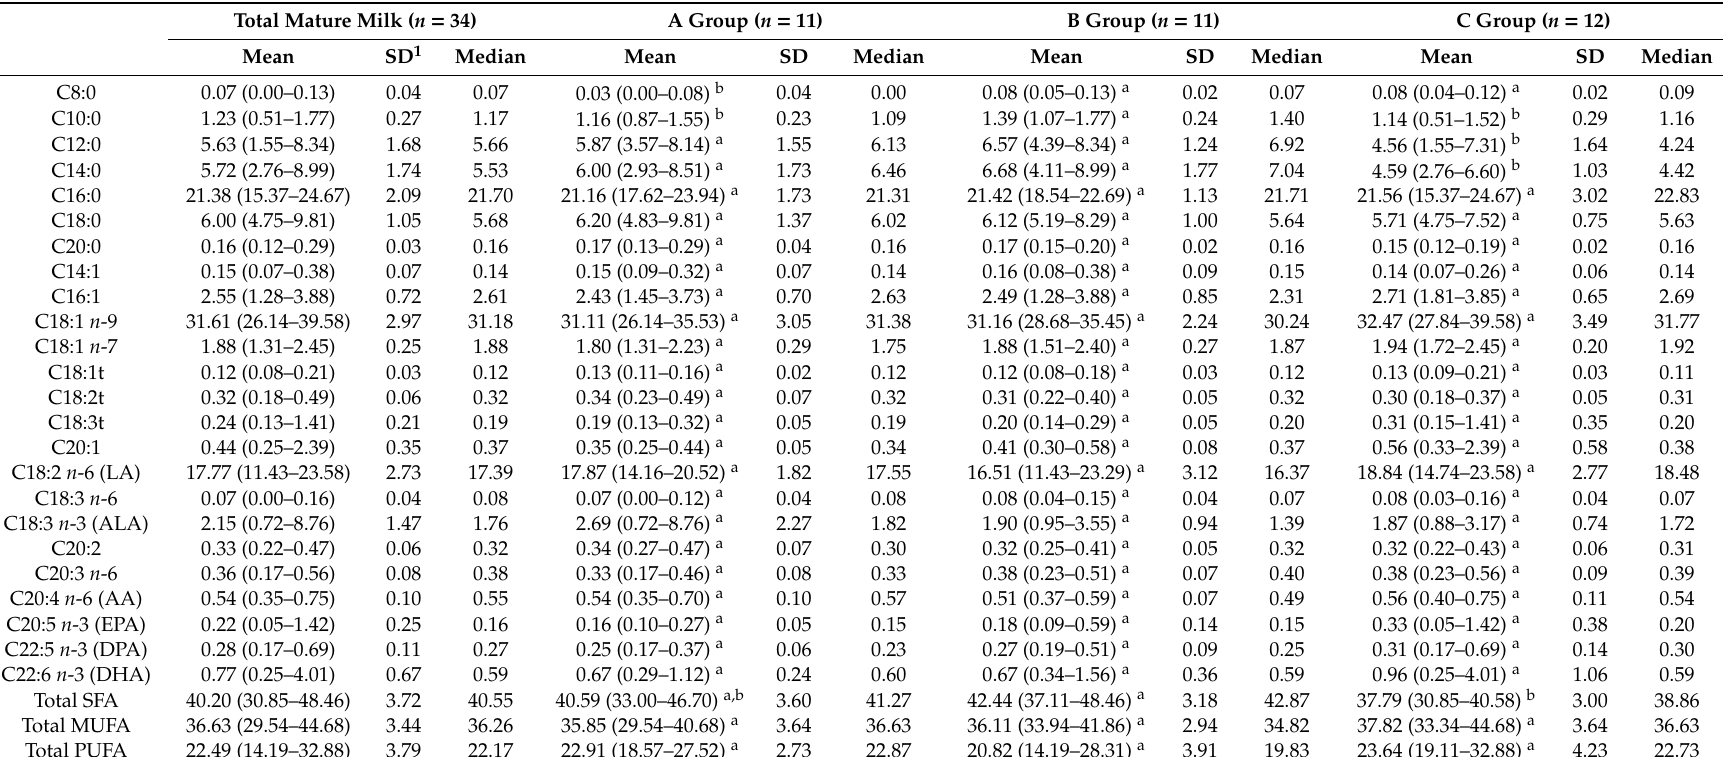
Table 4. Fatty acid compositions in human milk from mothers in Korea (% of total fatty acids